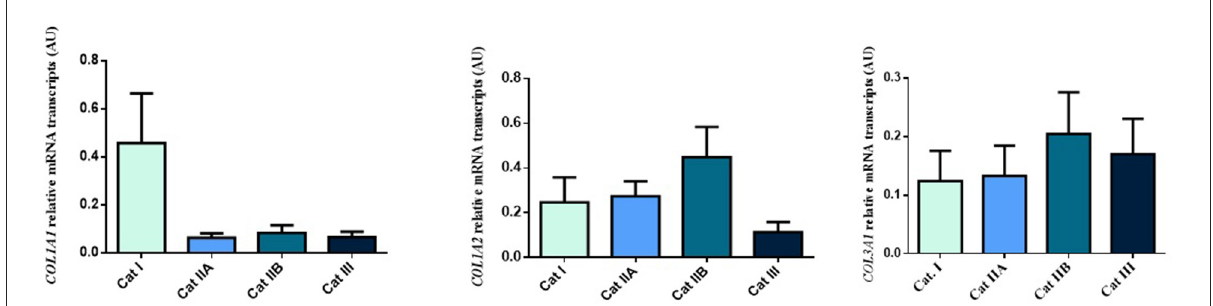
FIGURE1 Relative COL1A1, COL1A2 and COL3A1 mRNA transcripts in equine endometrium graded as Kenney and Doig’s categories I, IIA, IIB and III. Bars represent mean ± SEM.